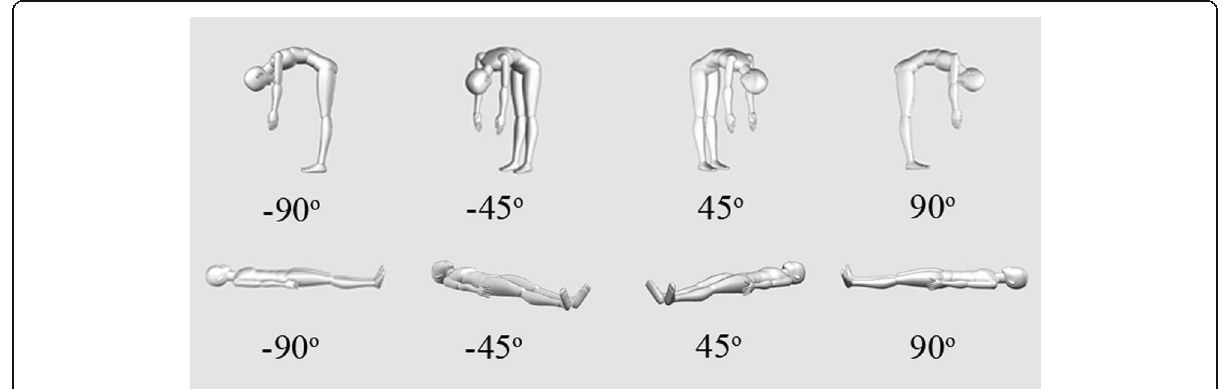
Fig. 14 Eight types of postural samples for training